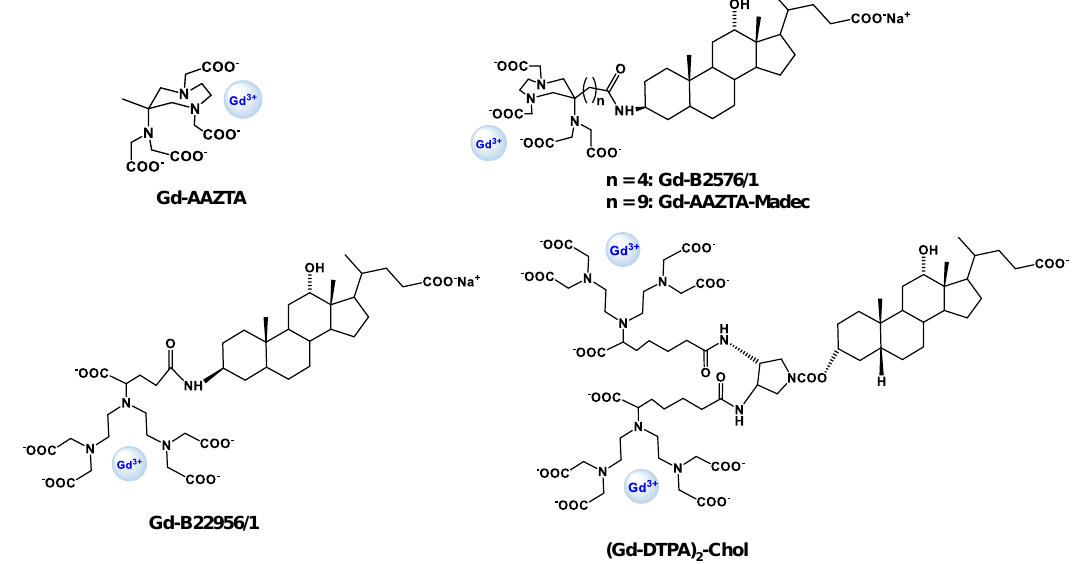
Scheme 1. Chemical structures of MRI agents designed for HSA